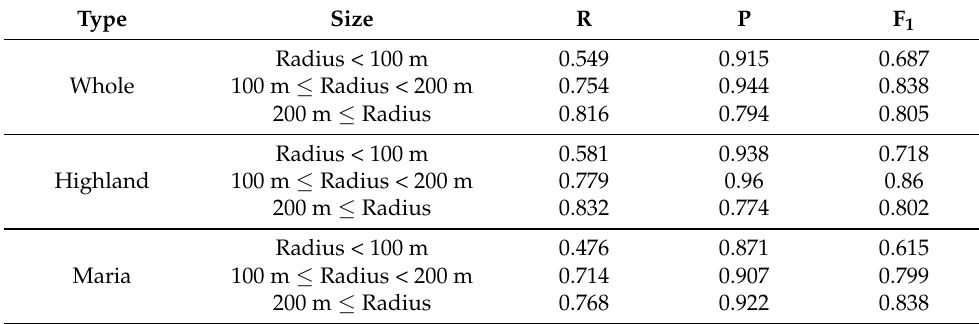
Table 5. Accuracy evaluation under different crater sizes.